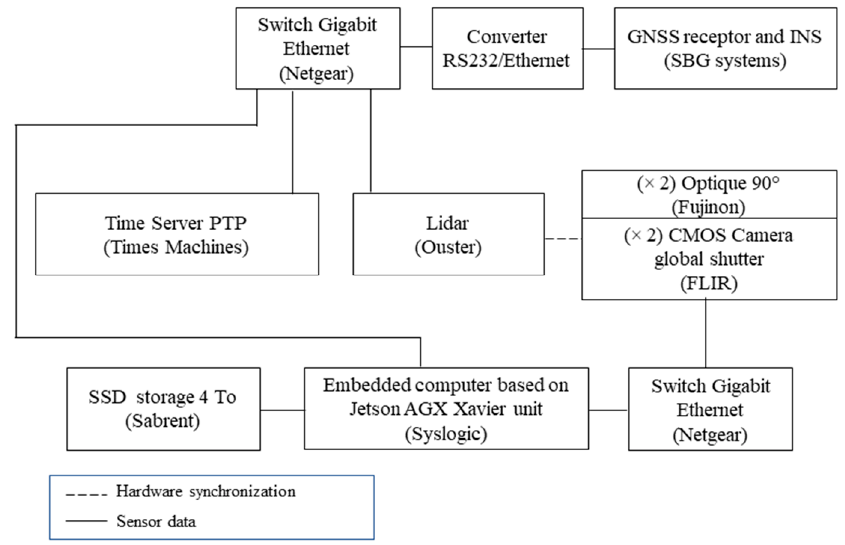
Figure 3. Data and synchronization communication scheme.